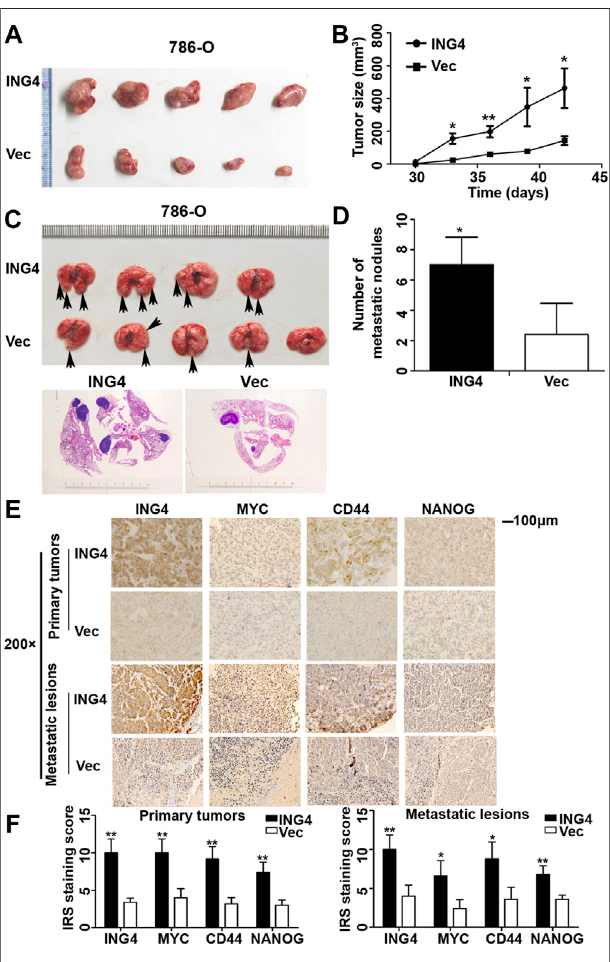
FIGURE 3 | ING4-promoted tumor growth and lung metastasis in vivo . (A – B) The picture of xenograft tumors and the size change of these tumors arising from ING4-overexpressed (ING4) and vector control (Vec) 786-O cells from 30 to 42 days. (C) The representative lung images of mice and HE staining of the lung in the stable ING4-overexpressed group (ING4) and control 786-O group (Vec). (D) The number of lung metastatic nodules was counted. (E – F) The representative IHC images and IRS staining scores of ING4, MYC, CD44, and NANOG in the primary tumors collected from the tumor-bearing experiment and metastatic lesions collected from the tail vein metastasis model (n = 5). IHC image magni fi cation, ×200; scale bar, 100 μ m; data were presented as mean ± standard deviation, * p < 0.05, ** p < 0.001.